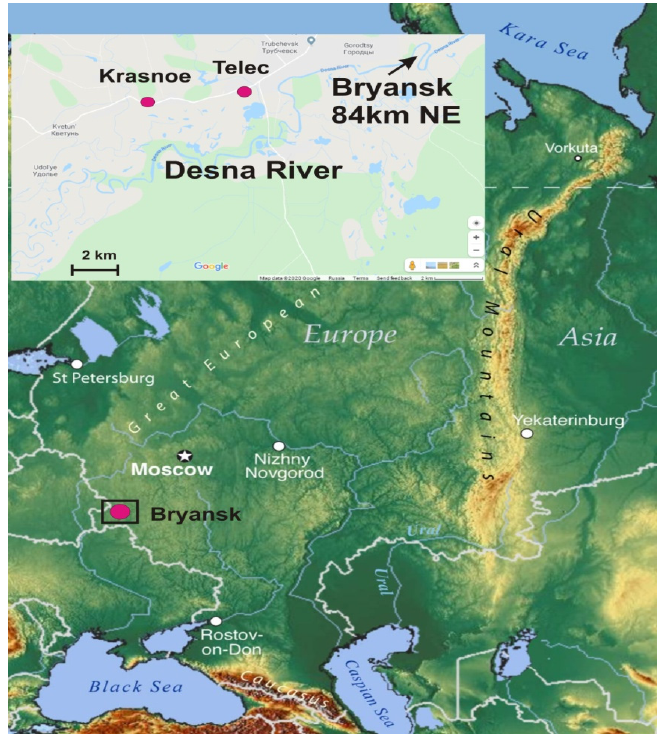
Figure 1. Location of studied sites, internet source; https://www.nationsonline.org/oneworld/map/European ‐ Russia ‐ map.htm. Also, the original feature of the investigated area is formation of different subtypes of soils associated with positions in microrelief: varieties with the second humus horizon are formed in plate ‐ shaped micro ‐ depressions; gleyic variants are formed in the middle parts of slopes and gley ones— at the footslopes and deeper depressions. The systems of micro ‐ depressions and micro ‐ elevations are well traced in the walls of the quarries Krasnoe and Telec on the right bank of the Desna River (Figure 2a). Second humus horizons were indicated in micro ‐ depression and depression of relief at the depth range 50–85 (Ab, Location 2 in Table A1 and Figure 2c) and 40–64 cm respectively (Ab, Location 3, Table A1).